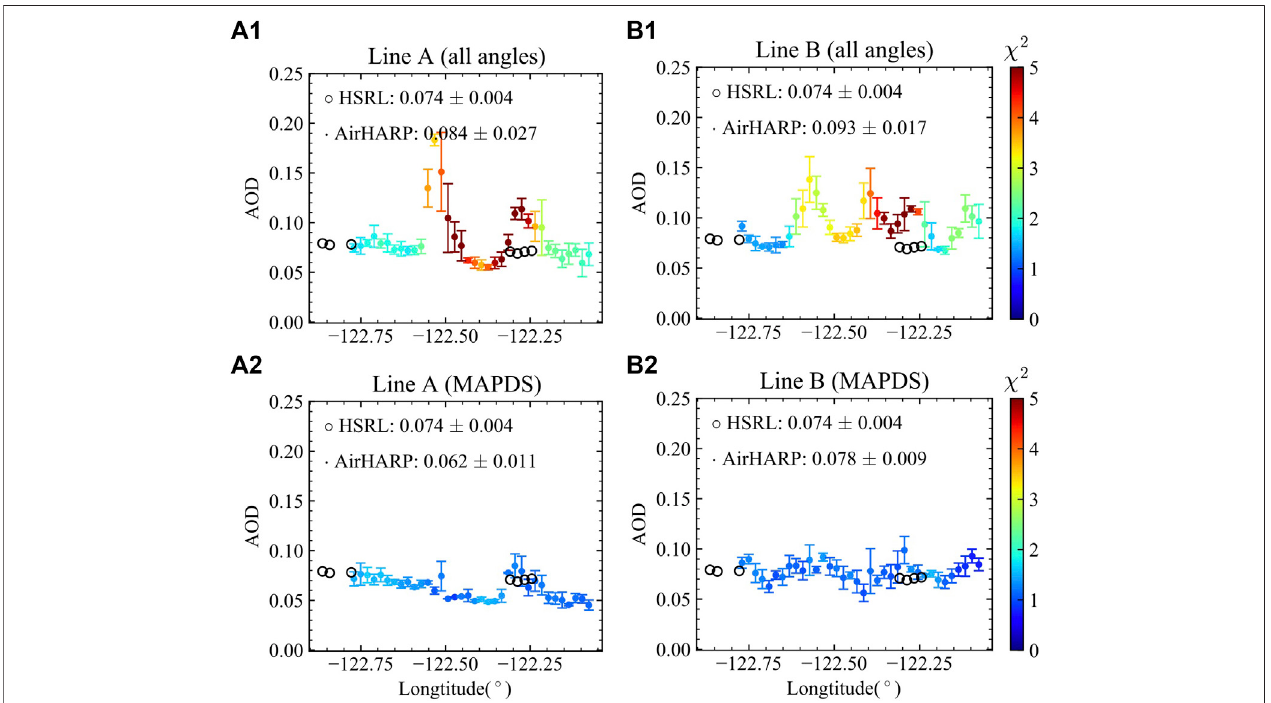
FIGURE 9 | Mean (colored dots) and standard deviation (bars) of the retrieved AirHARP AOD at 550 nm averaged over 4 × 4 pixels (2.2 km × 2.2 km ) for two along tracklinesacrosscloudpatchA(lineA, A1 – A2 )andcloudpatchB(lineB, B1 – B2 ).HSRLAODsat532 nmareindicatedbycircles.Fortheretrievalresultswithallangles (A1 – B1) ,mostpixelsconvergeinto χ 2 valueslargerthan2,butforretrievalswithMAPDS (A2 – B2) mostpixelsconvergedwithin χ 2 < 2.The χ 2 valueforthecorresponding AirHARP AODs are indicated by its color label in the